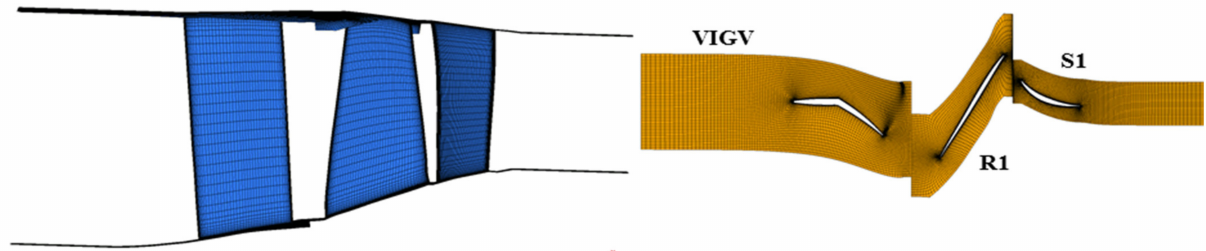
Figure 8. Computation mesh for the CFD